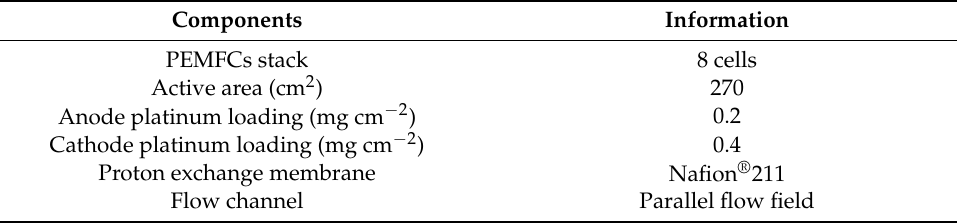
Table 1. Proton exchange membrane fuel cells (PEMFCs) stack components.